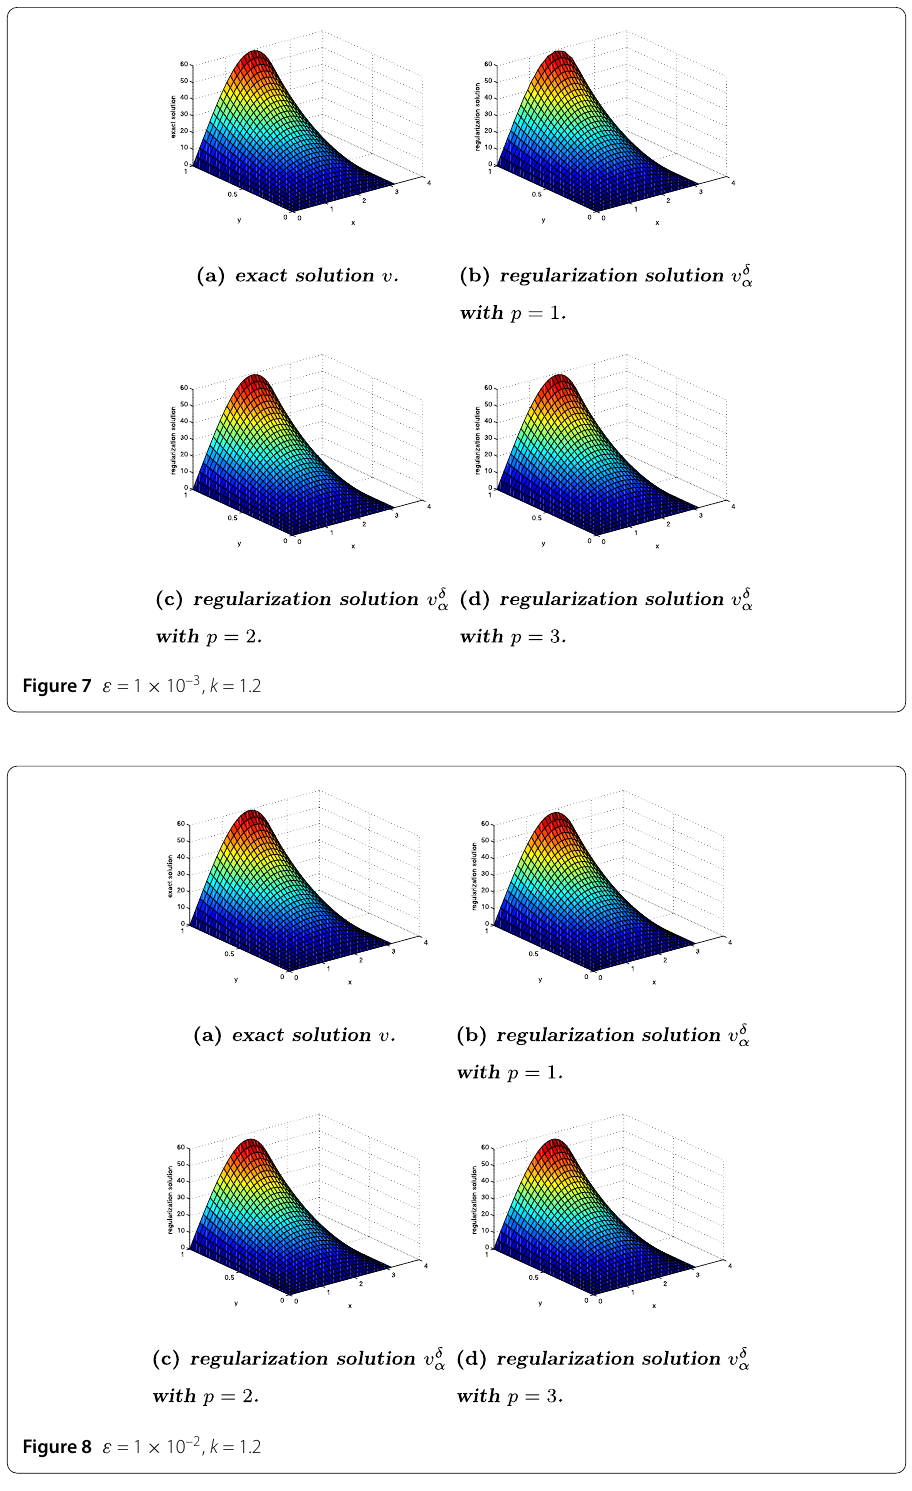
Figure 8 ε = 1 × 10 –2 , k =